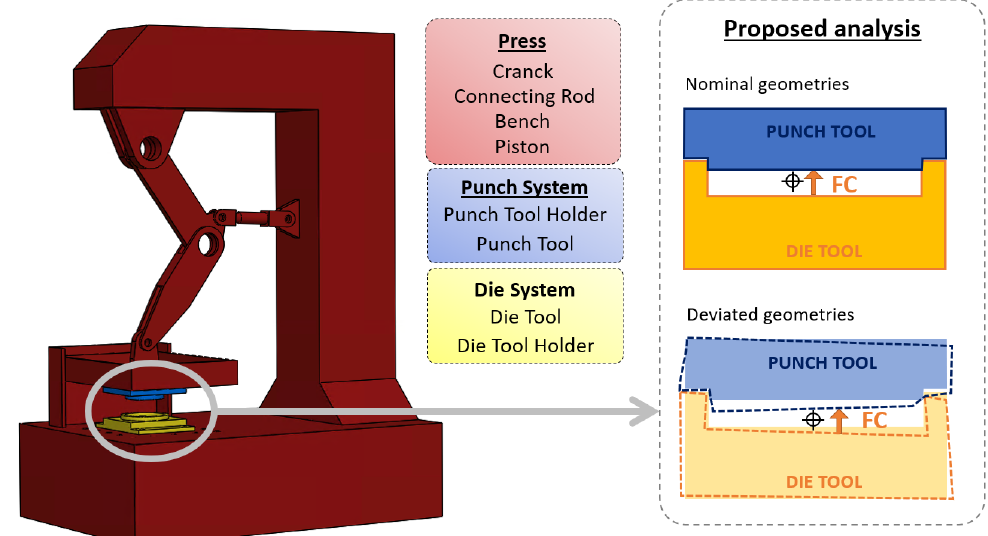
Figure 13. CAD representation of the coinage system and the Functional Condition to be analyzed. The following three subsections briefly describe the modeling process, corresponding to the three steps of the procedure described in Section 3.3. Due to space limitations, only a few diagrams are shown in each section to graphically show some examples of modeled elements. A color code was defined to identify each type of element represented in the diagrams: Artifacts (blue), Feature/TTRS ‐ based Feature representation (purple), GTs (green), Functional Condition (orange), mechanism configuration constraint (red), and analysis model and Functional Chains